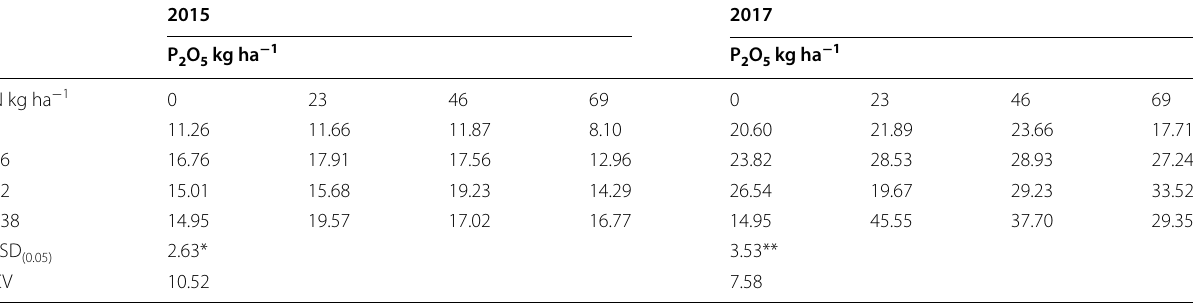
Table 6 Effect of nitrogen and phosphorus on tuber marketable yield of potato t ha − 1 at Kechin Abeba 2015 and 2017